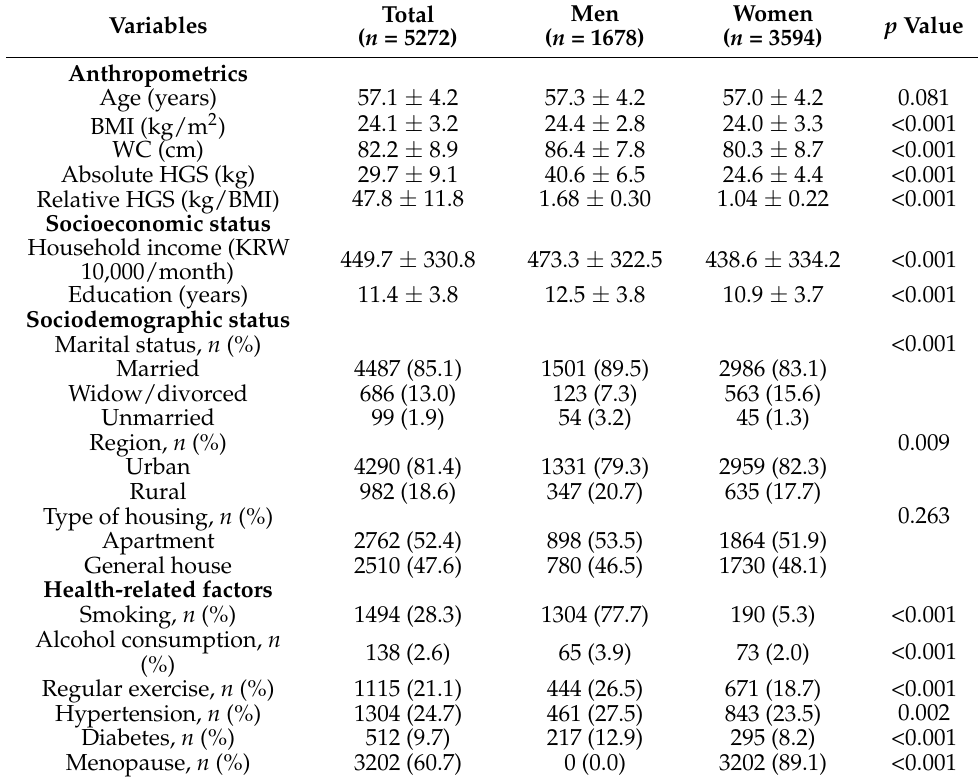
Table 1. Characteristics of the study